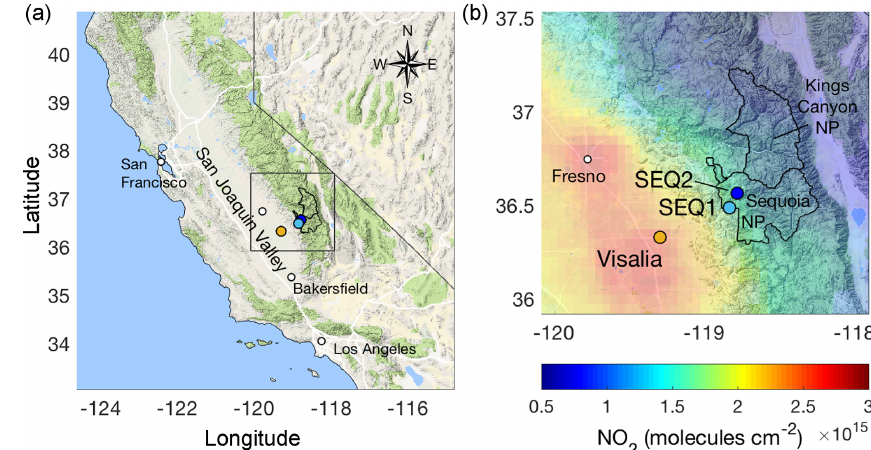
Figure 1. Map of California (a) with study region detail (b) indicating the locations of the SJV station, Visalia (orange), and two monitoring sites in SNP, SEQ1 (cyan) and SEQ2 (dark blue), with mean April–October 2010–2012 OMI NO 2 columns using the BEHR (Berkeley High-Resolution) product (Russell et al.,